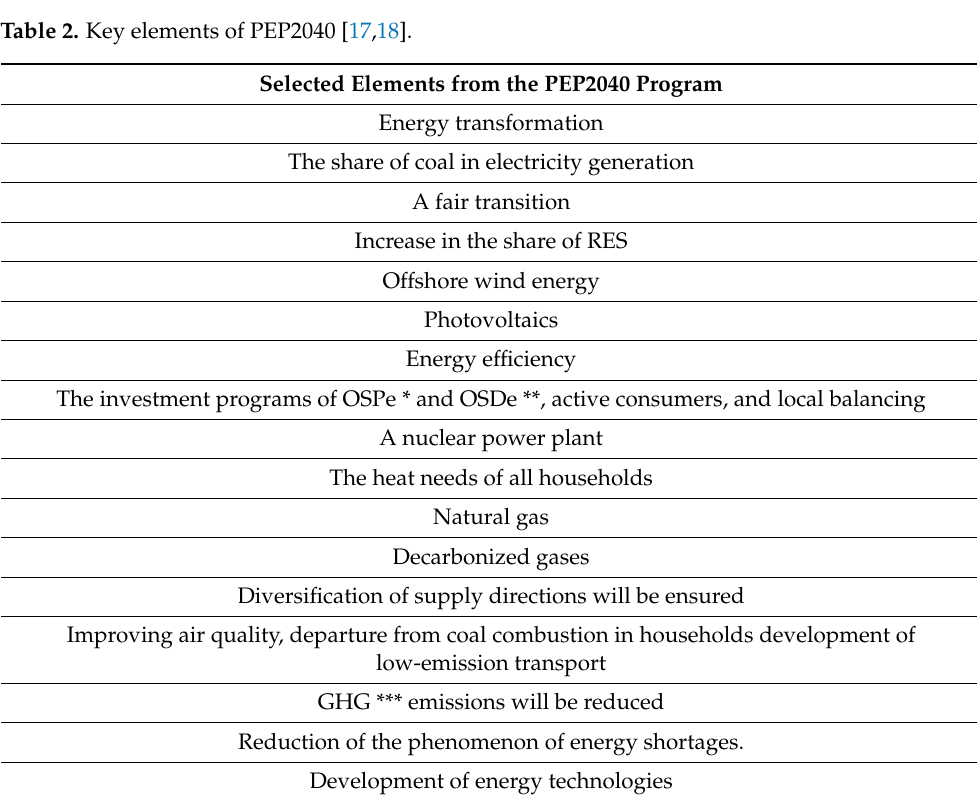
Table 2. Key elements of PEP2040